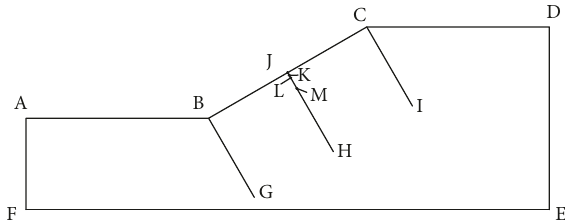
Figure 1: Heaviside step function.